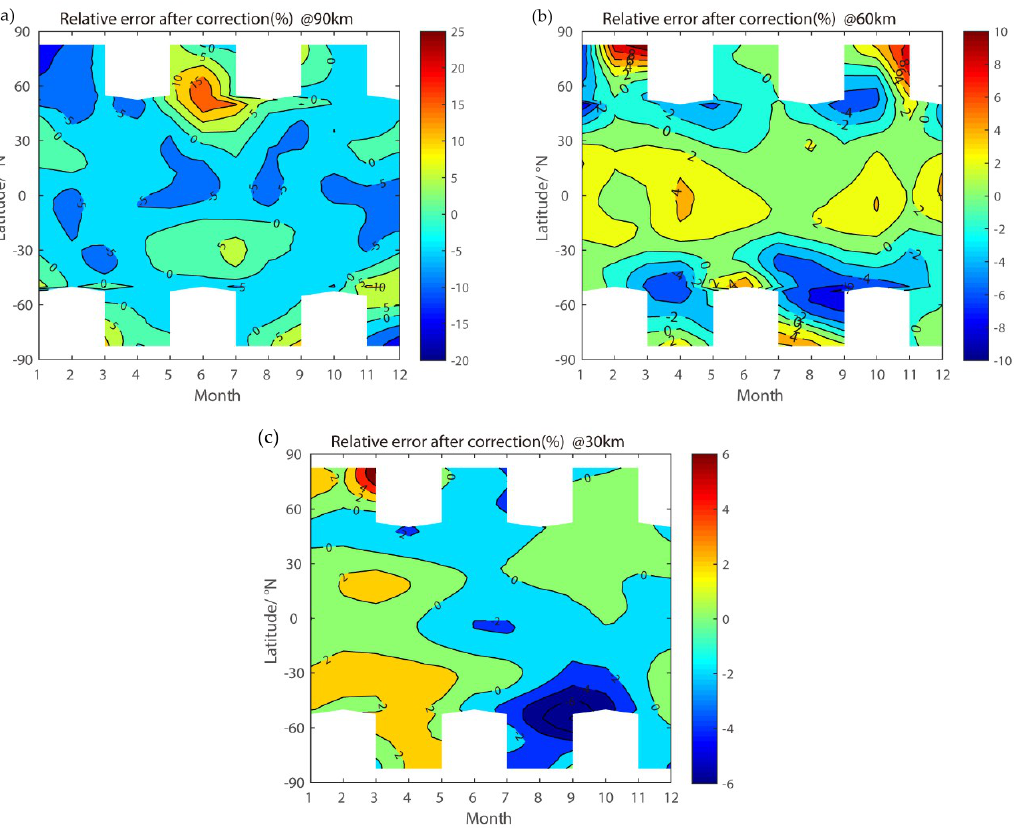
Figure 3. Same as Figure 1 but for zonal mean relative difference between NRLMSISE-00 and TIMED/SABER density after correction at ( a ) 90, ( b ) 60, and ( c ) 30 km.